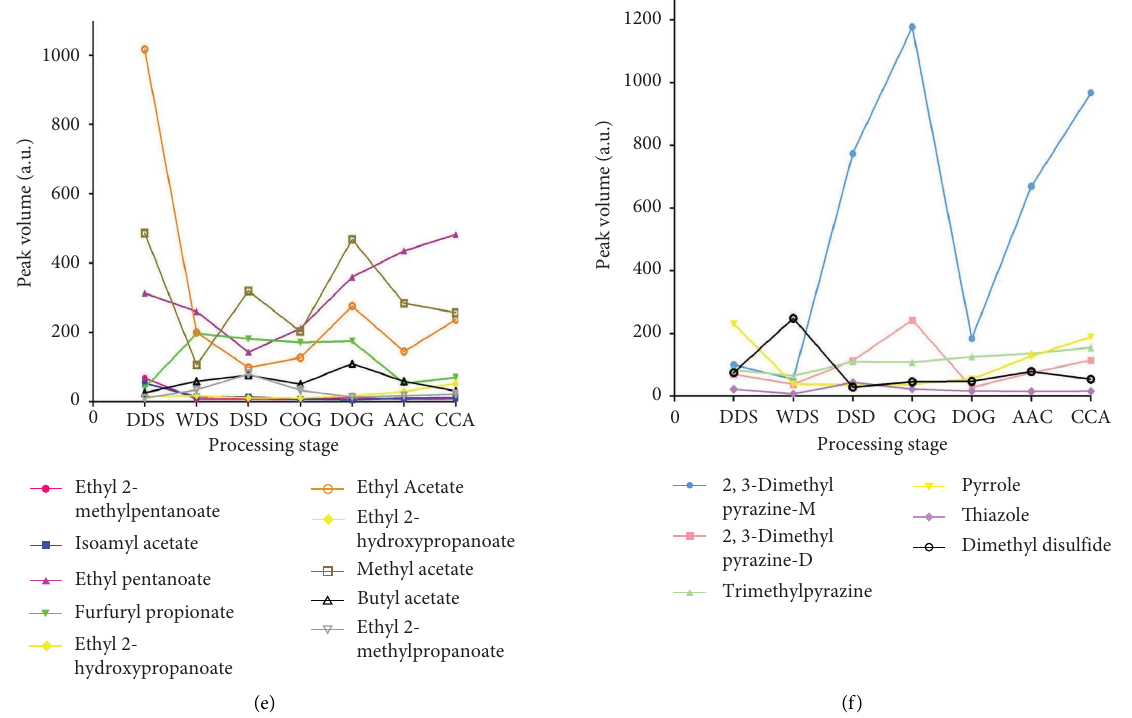
Figure 6: Relative contents and change curves of volatile favor compounds in Ejiao at diferent processing stages. (a, b) Alcohols, (c) aldehydes, (d) ketones, (e) esters, and (f) pyrazines, pyrrole, thiazole, and dimethyl